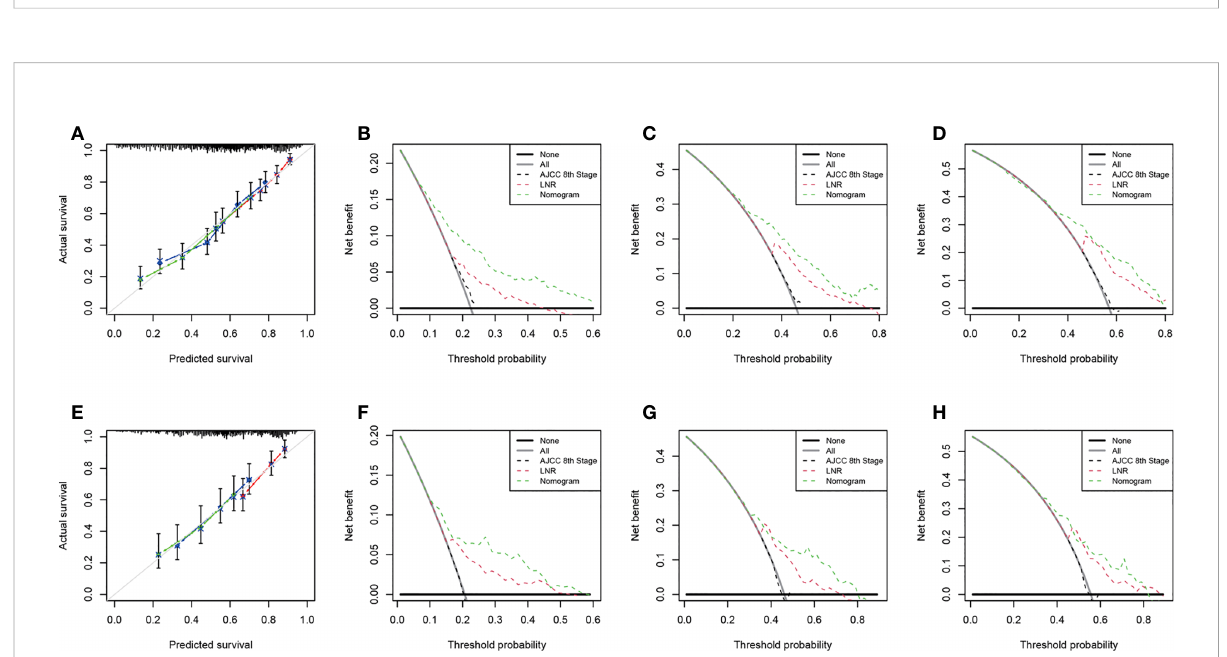
FIGURE 5 Calibration curves for CSS prediction in the training cohort (A) and the validation cohort (E) . Decision curve analysis of the AJCC 8th edition staging system, nomogram and LNR for the 1- (B) , 3- (C) and 5-year (D) CSS rates of PDA patients from the training cohort. Decision curve analysis of the AJCC 8th edition staging system, nomogram and LNR for the 1- (F) , 3- (G) and 5-year (H) CSS rates of PDA patients from the validation cohort. CSS, cancer-speci fi c survival; LNR, lymph node ratio; PDA, primary duodenal adenocarcinoma. For calibration curves, red, blue and green lines represent 1, 3, and 5 years,